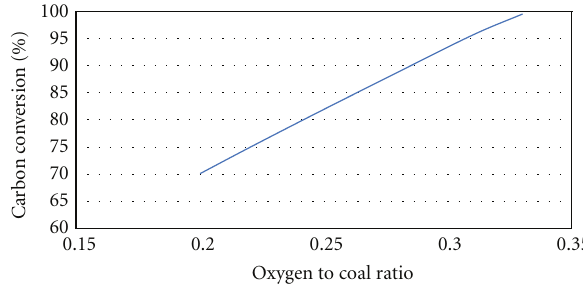
Figure 8: E ff ect of oxygen to coal ratio on carbon